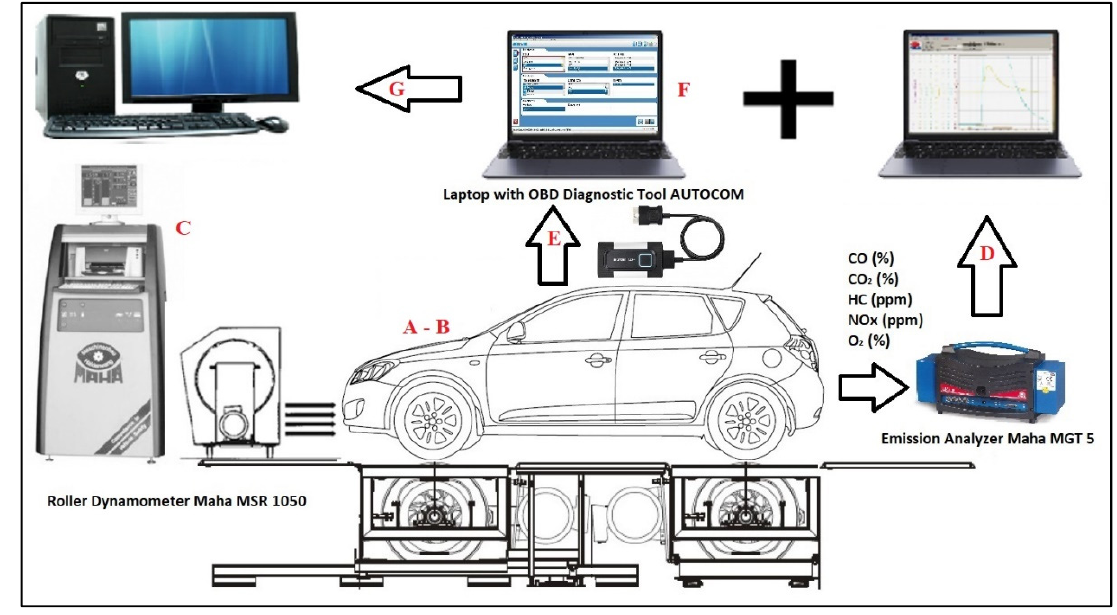
Figure 1. Research progress diagram (author).